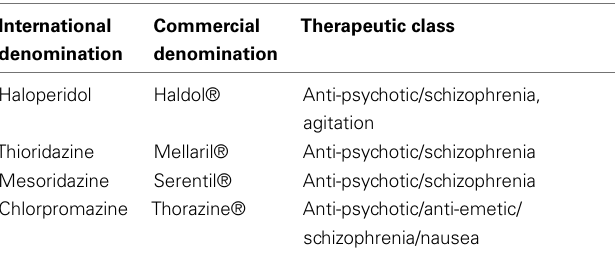
Table 4 | Psychotropic drugs, which in some studies, were weakly associated with QT interval prolongation and/or torsades de